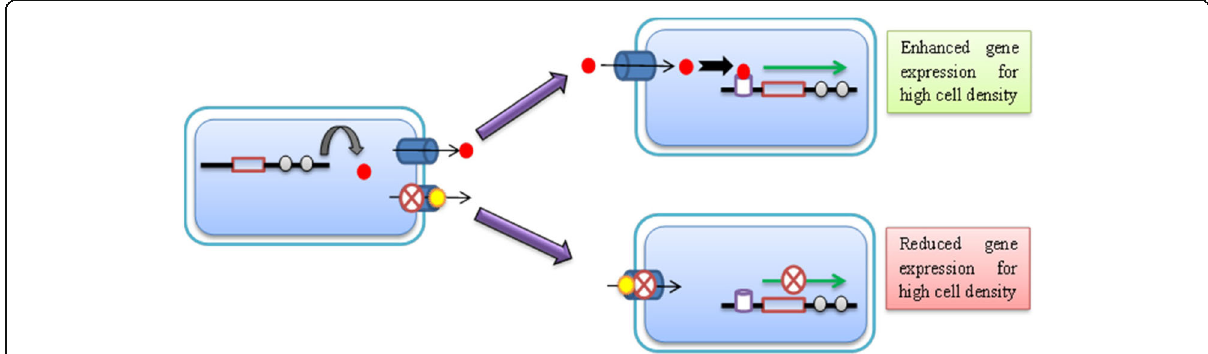
Fig. 1 Use of metal nanoparticles as an efflux pump inhibitor to impede extrusion of quorum-sensing signaling molecules ( red filled circle ) outside bacterial cells with the help of metal nanoparticles ( yellow filled circle ) to block efflux pump ( filled cylinder ) resulting in reduced binding of signaling molecule to its receptor ( empty cylinder ) and hindrance in biofilm